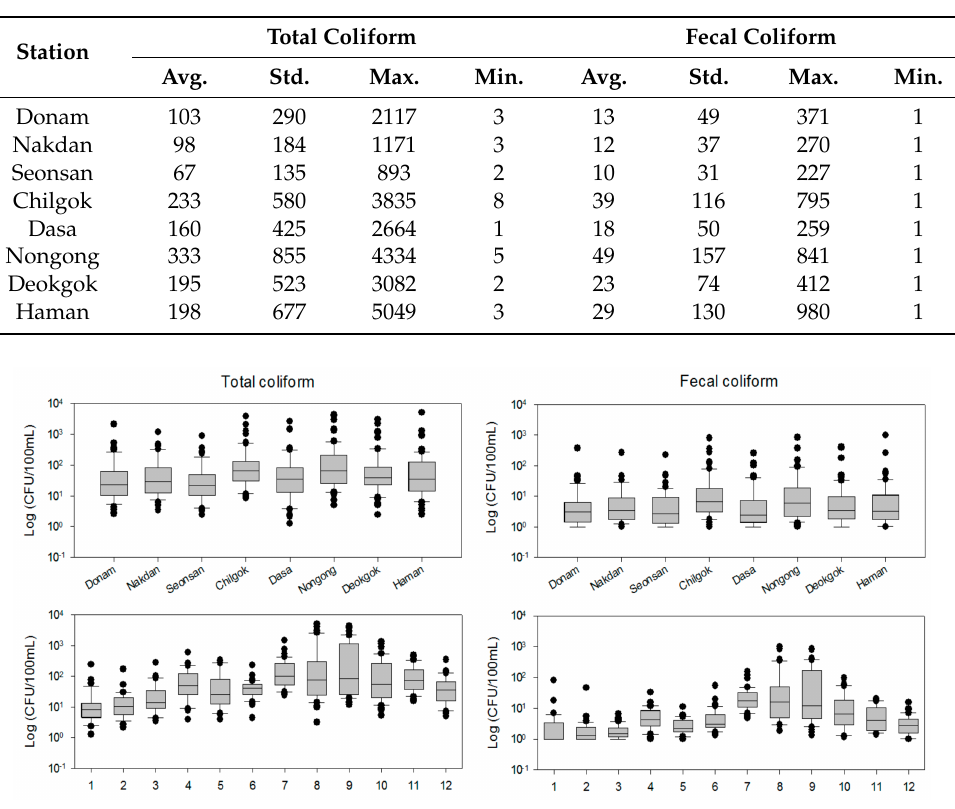
Table 1. Statistics of total and fecal coliforms at each weir station of the Nakdong River (in CFU / 100mL).